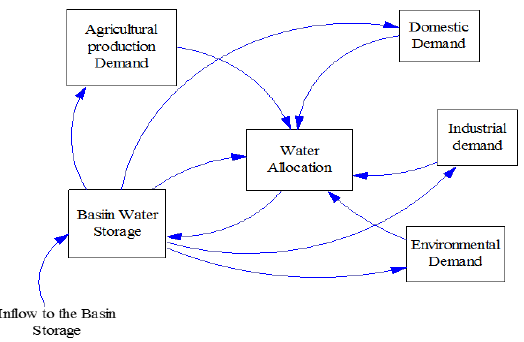
Figure 2. Causal Loop Diagram for the water system model